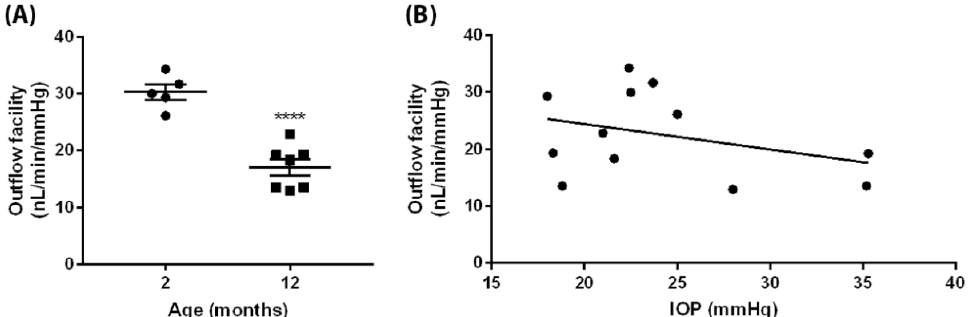
Figure 3. Total aqueous humor outflow facility in young and aged egl1 animals. ( A ) The aged animals demonstrated significantly lower outflow facility compared to the young animals. Data are presented as means ± SEM ( n = 5 and 7 for 2- and 12-months old animals, respectively). ****: p < 0.001. ( B ) Individual outflow facility was plotted against IOP measurement. The outflow facility and IOP measurement show a trend of negative correlation, but this did not achieve statistical significance.